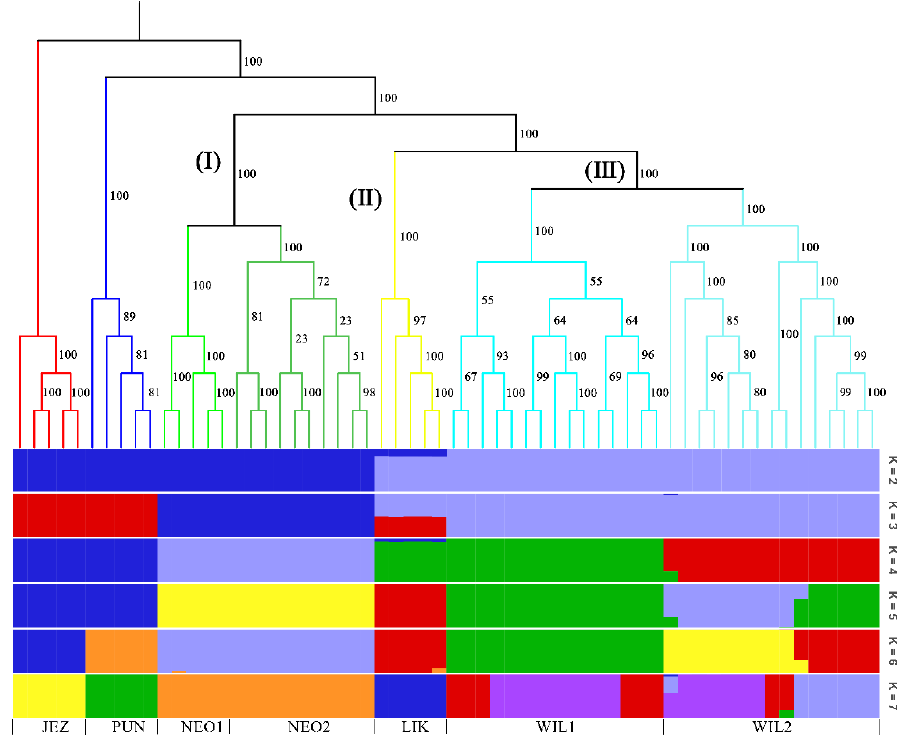
Figure 1. Maximum likelihood tree and structure analysis histogram of five spruce species based on SNP markers. JEZ, P. jezoensis ; PUN, P. pungens ; NEO1, P. neoveitchii from Gansu; NEO2, P. neoveitchii from Shaanxi; LIK, P. likiangensis ; WIL1, P. wilsonii from Shanxi; WIL2, P. wilsonii from Hubei. The colors in the upper part of the figure represent different groups and the colors in the lower part of the figure represent different genetic components.